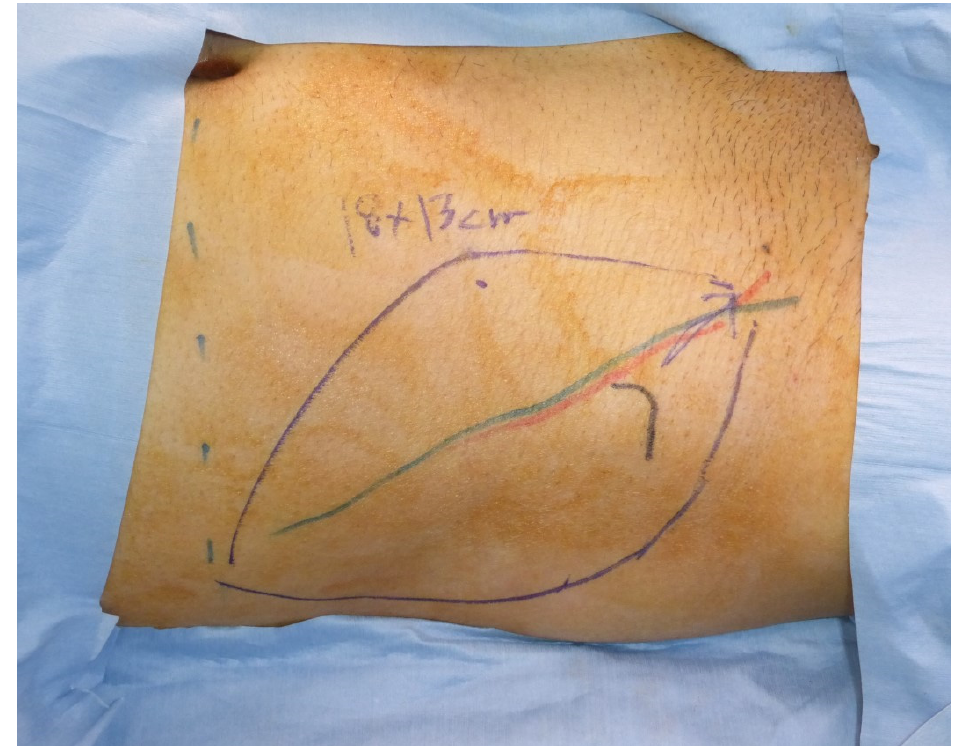
Figure 2. An 18 × 13 cm SCIP flap was designed based on a preoperative marking of the superficial branch of the SCIA.